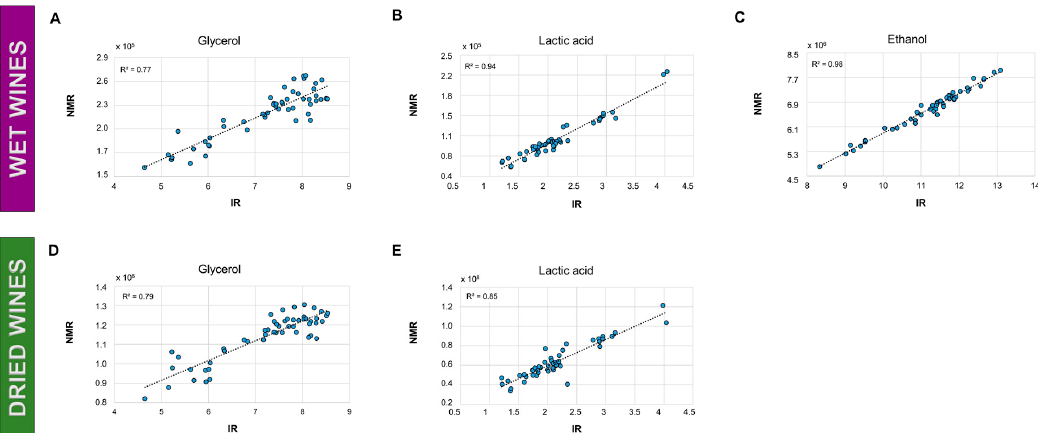
Figure 4. Correlations of NMR (intensities/integrals) to IR calibrated concentrations (WineScan). NMR-IR correlations for glycerol ( A ), lactic acid ( B ), and ethanol ( C ) as measured in wet wine samples. NMR-IR correlations for glycerol ( D ) and lactic acid ( E ) as measured in the dried wine samples.